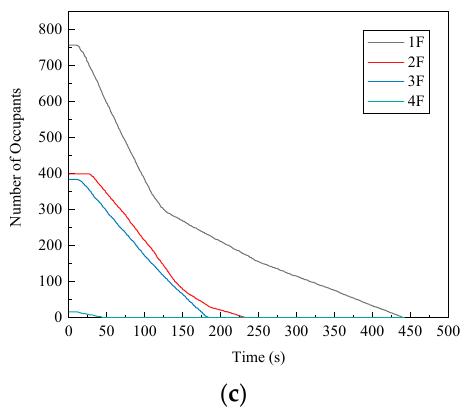
Figure 17. Changes in the number of occupants on each floor over time. ( a ) Change in the number of occupants of Case1A; ( b ) change in the number of occupants of Case2A; ( c ) change in the number of occupants of Case25A. Table 6. Evacuation time for the occupants of each floor in all cases.